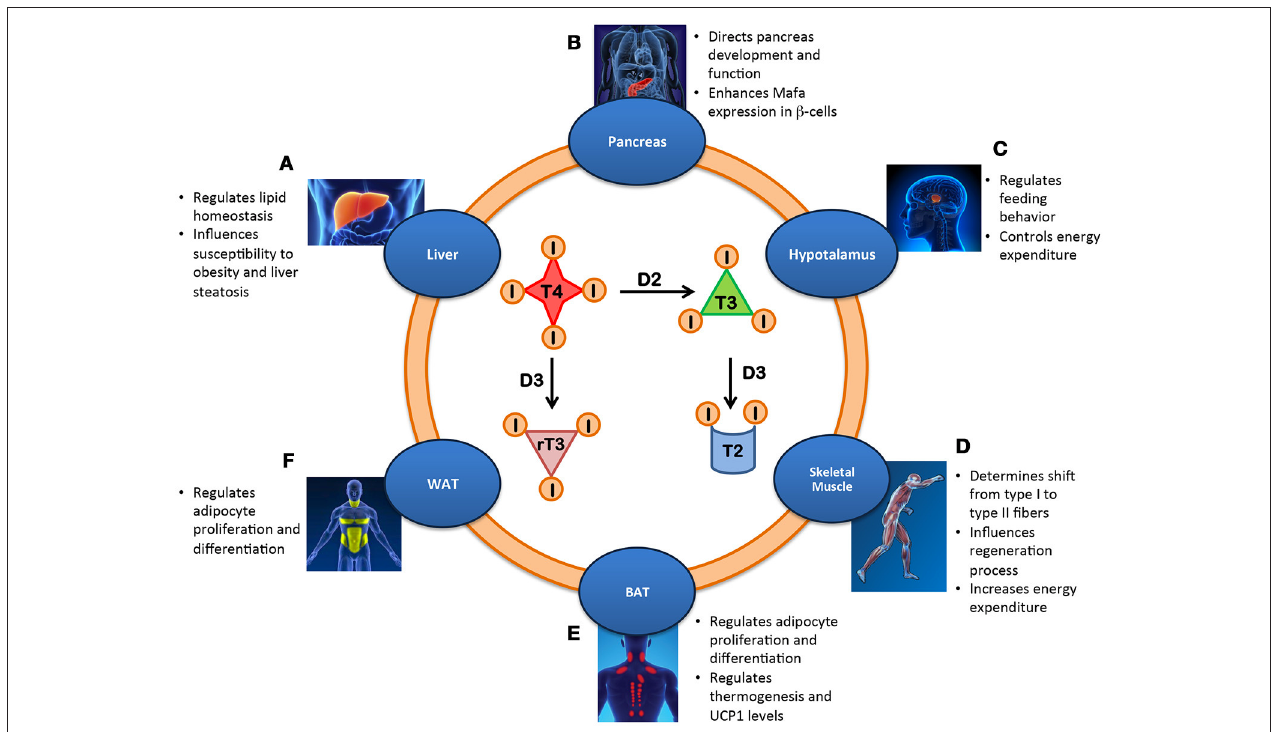
FIGURE 1 | Metabolic effects of the intracellular regulation of thyroid hormone in different tissues. (A) Liver: Lipid homeostasis is regulated by local T3 level thereby influencing susceptibility to obesity and liver steatosis. (B) Pancreas: The balance between the deiodinases controls the development and function of β -cells by enhancing Mafa transcription factor and inducing insulin secretion. (C) Hypothalamus: Local availability of TH regulates feeding behavior and controls energy expenditure. (D) Skeletal Muscle: Increased T3 levels in skeletal muscle promote the shift from type I to type II fibers, influence regeneration and increase energy expenditure. (E) BAT: D2-mediated TH activation regulates UCP1 expression and thermogenesis, adipocyte proliferation and differentiation and body weight. (F) WAT: Local T3 metabolism regulates adipocyte